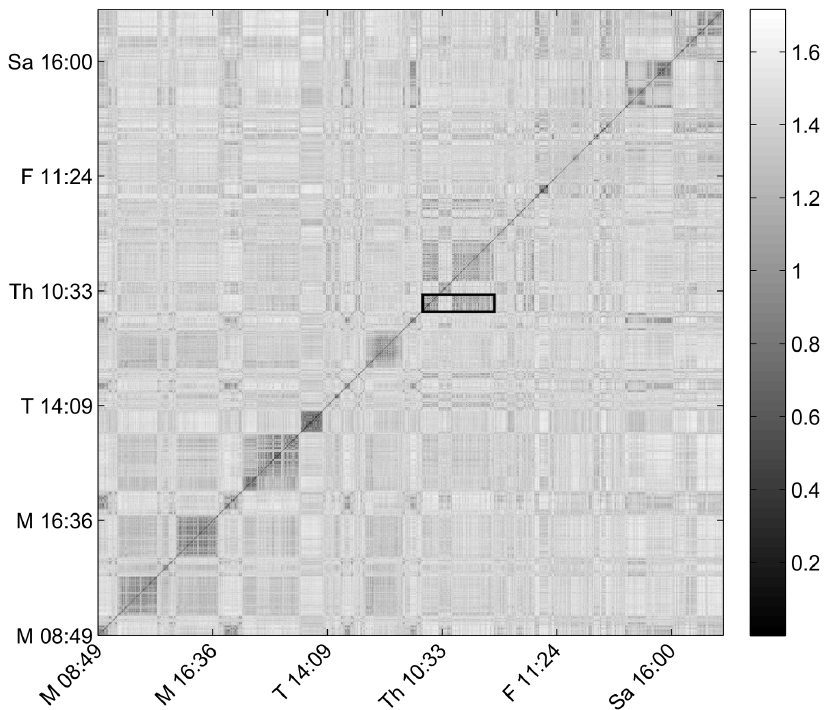
Figure 1. Recurrence plot for NV’s images. The images are ordered in time on both X and Y axes. The substantial dark structure around the diagonal implies that similar visual contexts were visited close in time. The off-diagonal structures represent recurrent visits to similar visual contexts at different points in time. doi:10.1371/journal.pone.0097166.g001 color correlogram [15] (see Figure S1 and Information S1 for a comparison between the color correlogram and the color histogram representations of a simple image). The justification for the choice of representation is based on the common neighbor ratio [16] (see Figure S2 and Figure S3). Following the analysis in